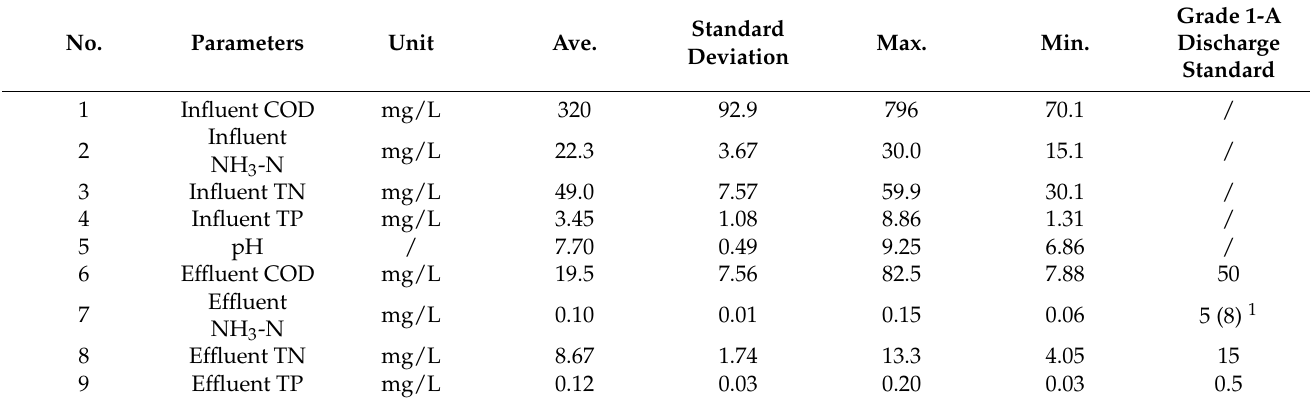
Table 1. Statistics of WWTP influent and effluent water quality data for the study